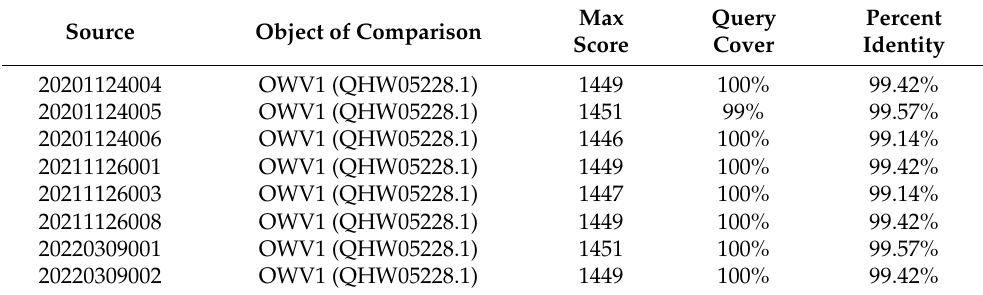
Table 5. Alignment of the RNA-directed RNA polymerase (RdRp) amino acid sequence of oriental wenrivirus 1 (OWV1) isolated from wild P. chinensis with the corresponding sequence of OWV1 previously isolated from farmed P. chinensis . Max Query Percent Source Object of Comparison Score Cover Identity 20201124004 OWV1 (QHW05228.1) 1449 100% 99.42% 20201124005 OWV1 (QHW05228.1) 1451 99% 99.57% 20201124006 OWV1 (QHW05228.1) 1446 100% 99.14% 20211126001 OWV1 (QHW05228.1) 1449 100% 99.42% 20211126003 OWV1 (QHW05228.1) 1447 100% 99.14% 20211126008 OWV1 (QHW05228.1) 1449 100% 99.42% 20220309001 OWV1 (QHW05228.1) 1451 100% 99.57% 20220309002 OWV1 (QHW05228.1) 1449 100%